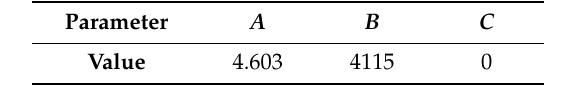
Figure 3. Comparison of saturation pressure curves. Table 1. Fitted Antoine equation